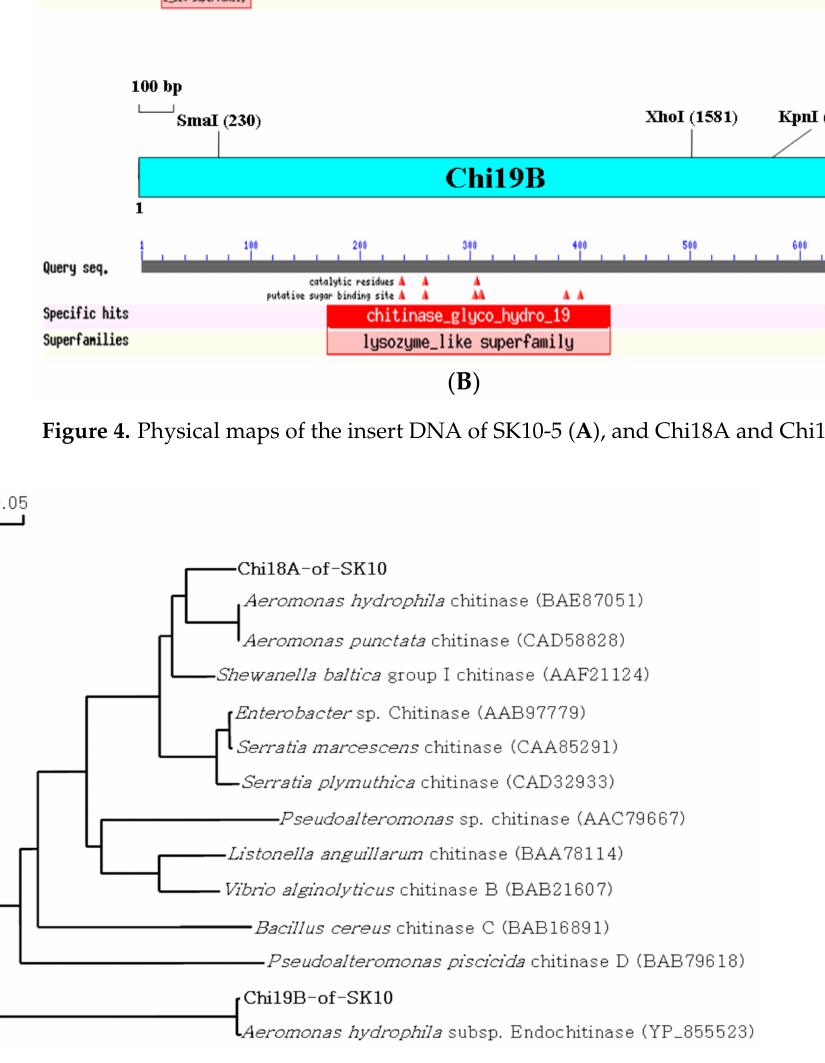
Figure 5. Phylogenetic tree of the Chi18A and Chi19B proteins. The phylogenetic tree shows the evolutionary relatedness and levels of homology between the chitinolytic enzymes. The phyloge- netic tree was constructed using the maximum likelihood method with bootstrap trials of 1000 in